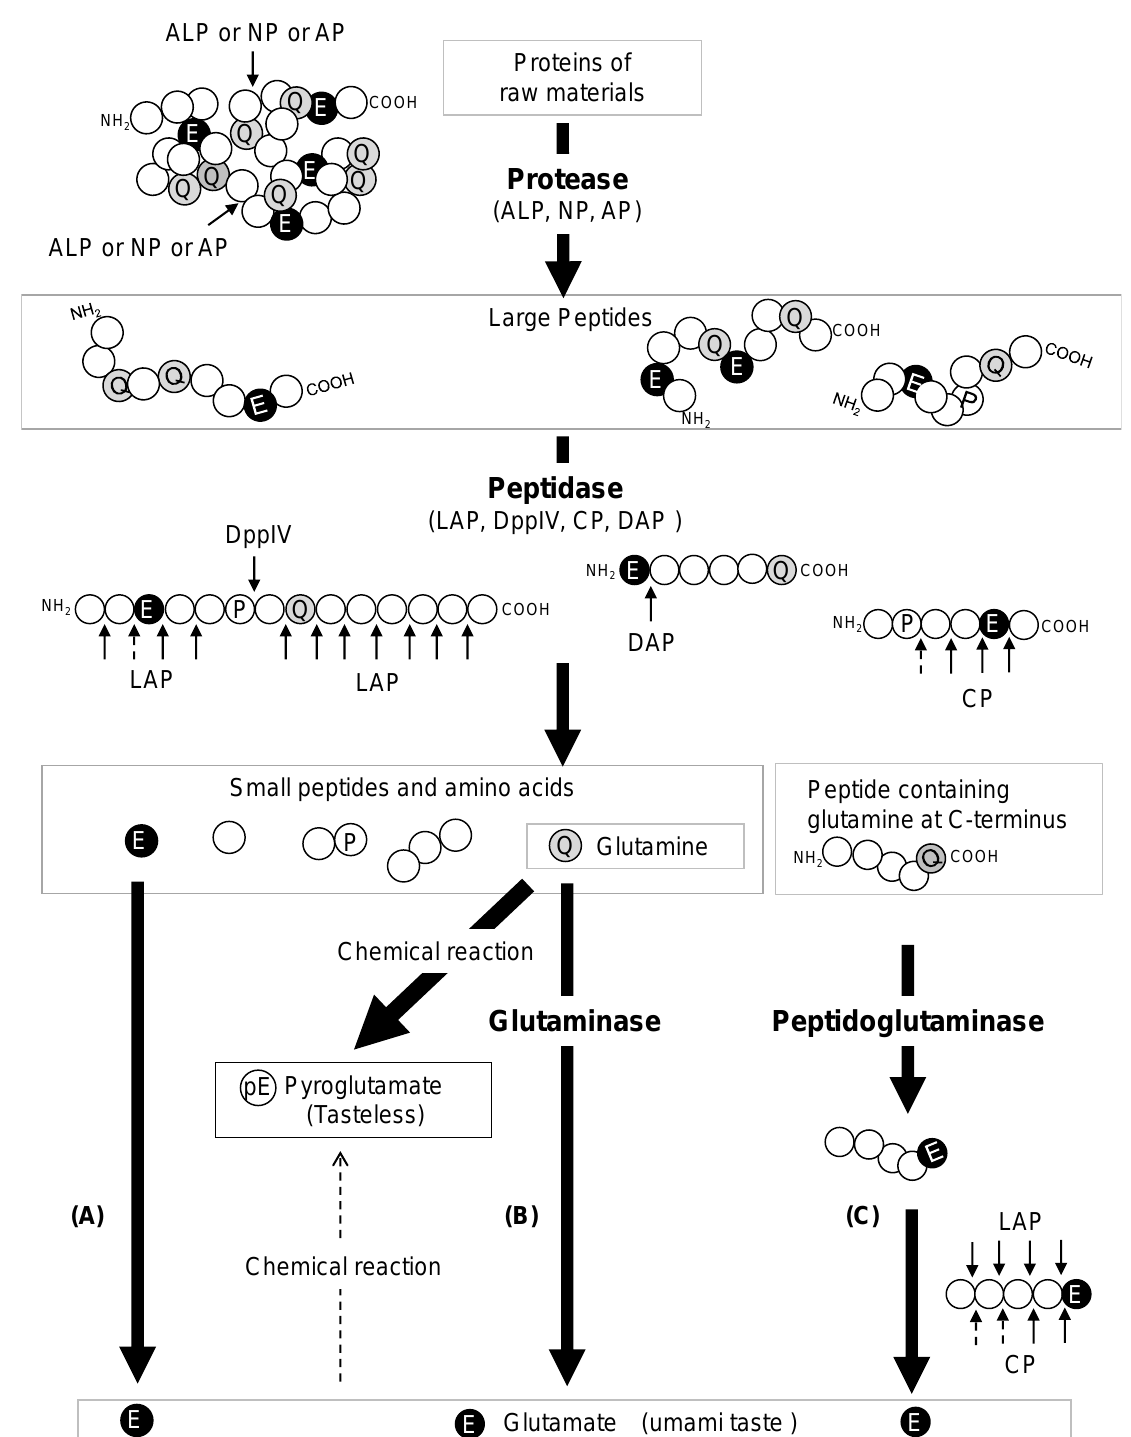
Figure 2. Mechanism of glutamate production in soy sauce fermentation. L-glutamate is produced via three pathways: ( A ) direct release from raw material proteins by proteases and/or peptidases, ( B ) glutaminase-mediated hydrolysis of free l-glutamine released from material proteins, and ( C ) release from peptidyl C-terminal l-glutamate residues that are deamidated by peptidoglutaminase. Pyroglutamate is non-enzymatically converted from l-glutamine and l-glutamate, but l-glutamine is converted to pyroglutamate much more efficiently than l-glutamate. The dotted arrows indicate the low efficiency of protease hydrolysis and chemical conversion. ALP, alkaline proteases; NP, neutral proteases; AP, aspartic proteases; LAP, leucine aminopeptidase; DppIV, dipeptidyl aminopeptidase; DAP, aspartyl aminopeptidase; CP, carboxyl peptidase. The circles in the figure represent amino acids: E for glutamic acid, Q for glutamine, pE for pyroglutamic acid and P for